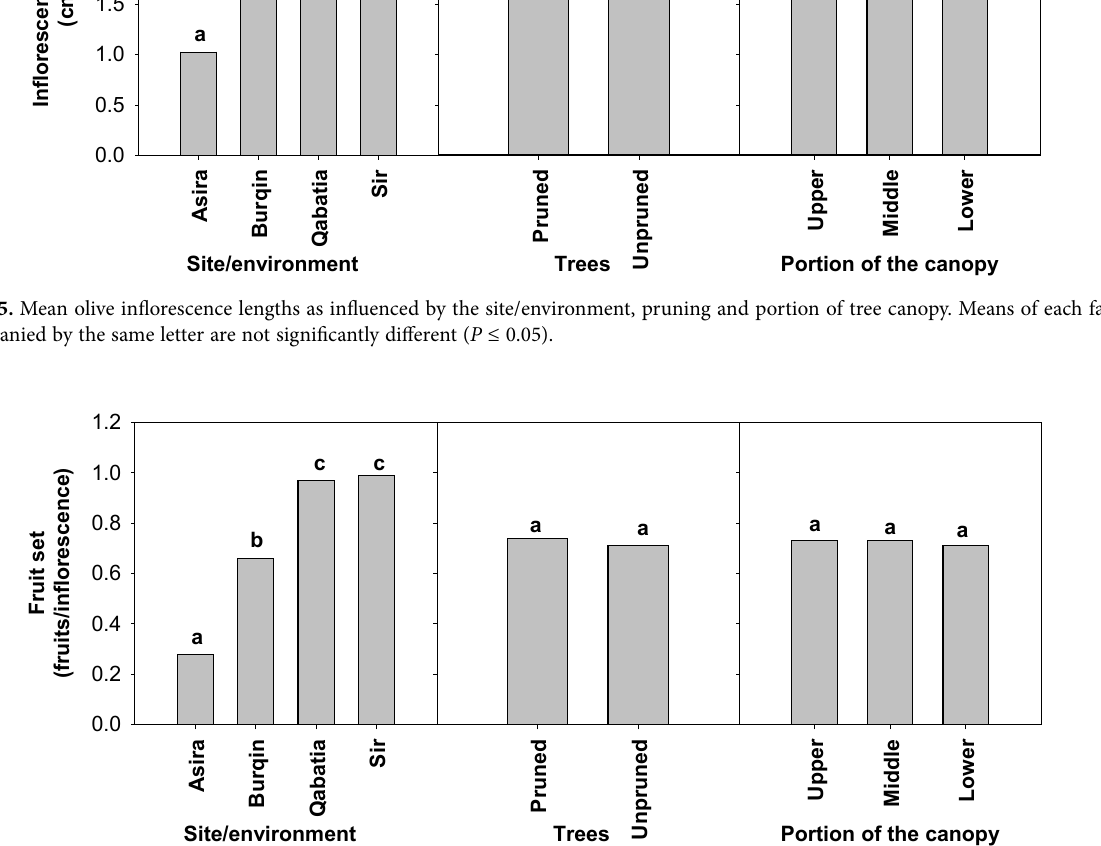
Figure 6. Mean fruit set values for olive trees as influenced by the site/environment, pruning and portion of tree canopy. Means of each fac- tor accompanied by the same letter are not significantly different ( P ≤